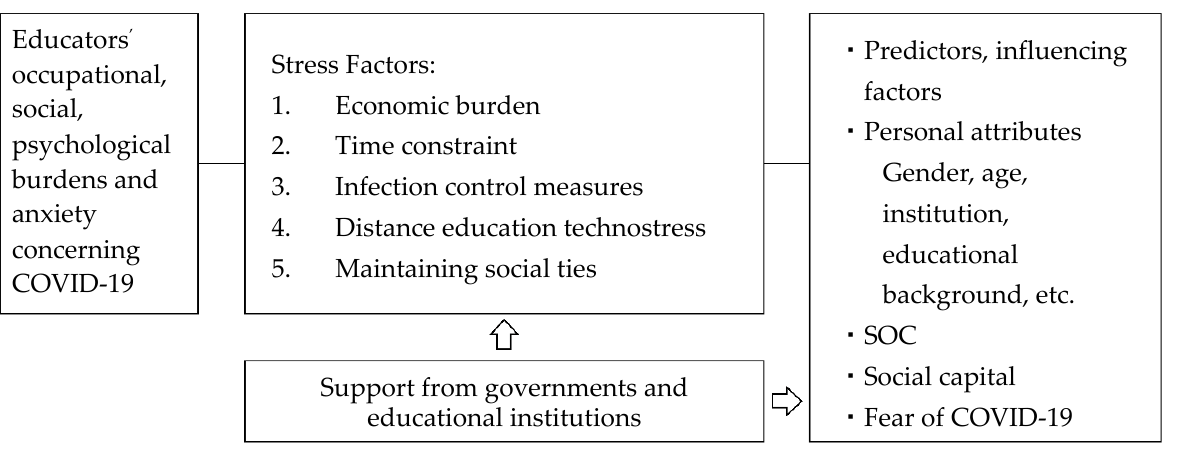
Figure 1. The burden of educators and the impact on the educational environment during COVID-19. (SOC = sense of coherence). We formulated this figure of analytical approach to the social and psychological burden imposed by COVID-19 on educators, by referring to the method of NIOSH approach to Job Stress [44,45].